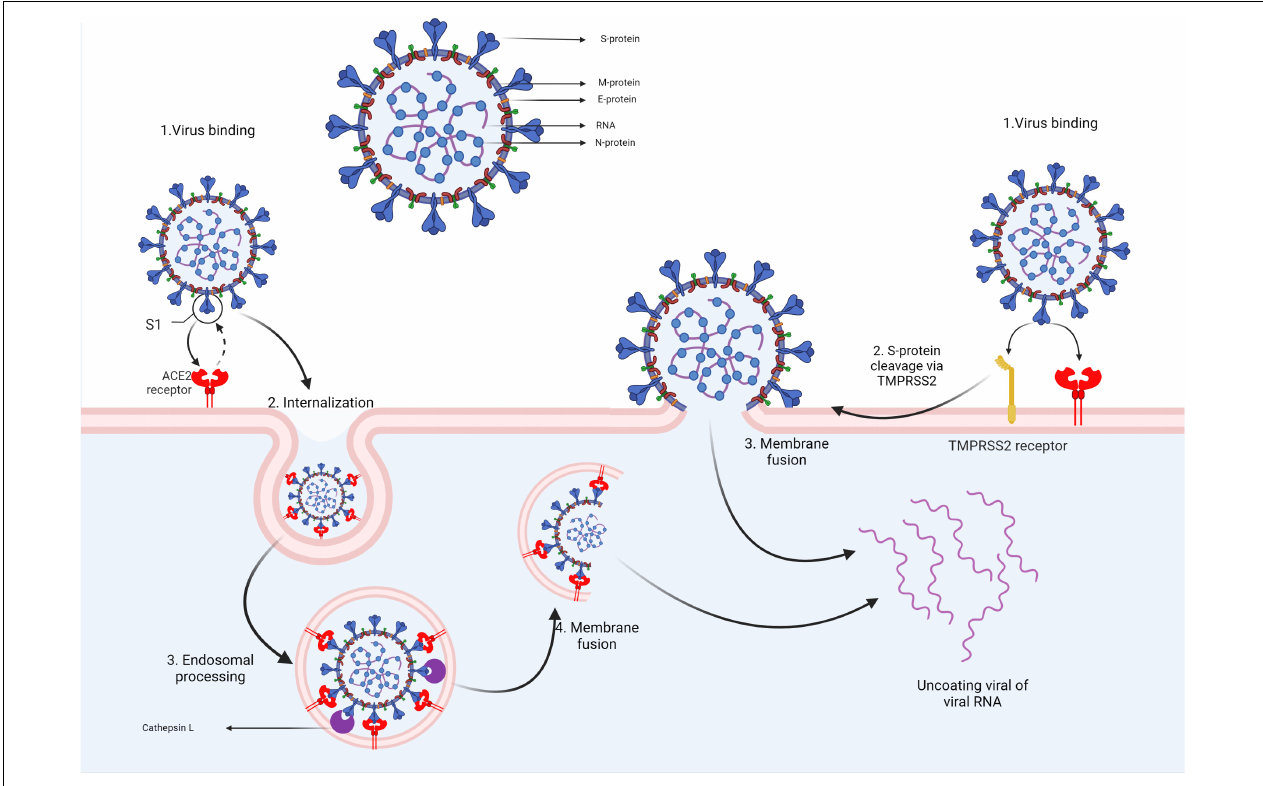
FIGURE 2 | Coronavirus structure and cell entry